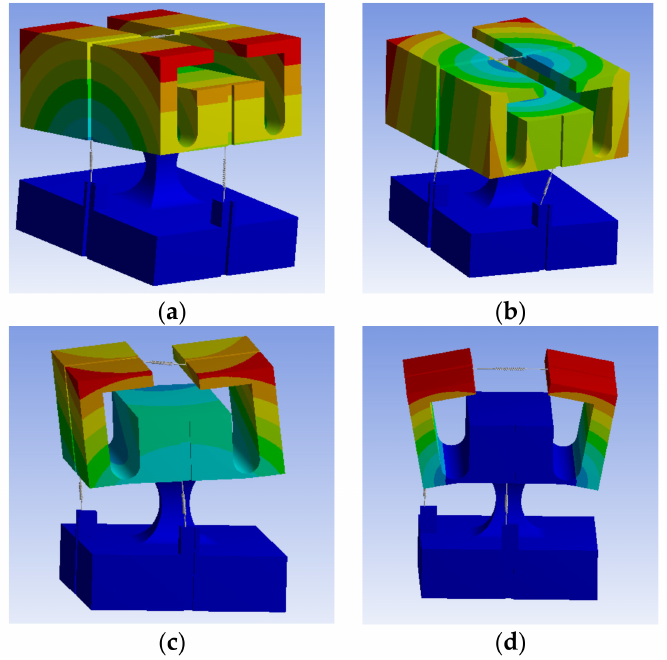
Figure 14. ( a ) First-, ( b ) second-, ( c ) third-, and ( d ) fourth-order